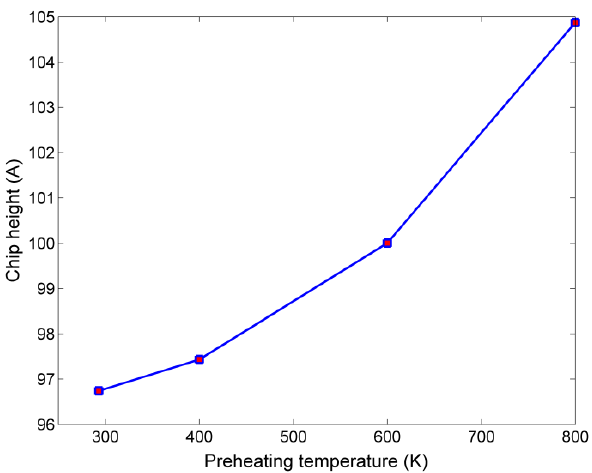
Figure 4. Chip height variation with respect to preheating temperature.